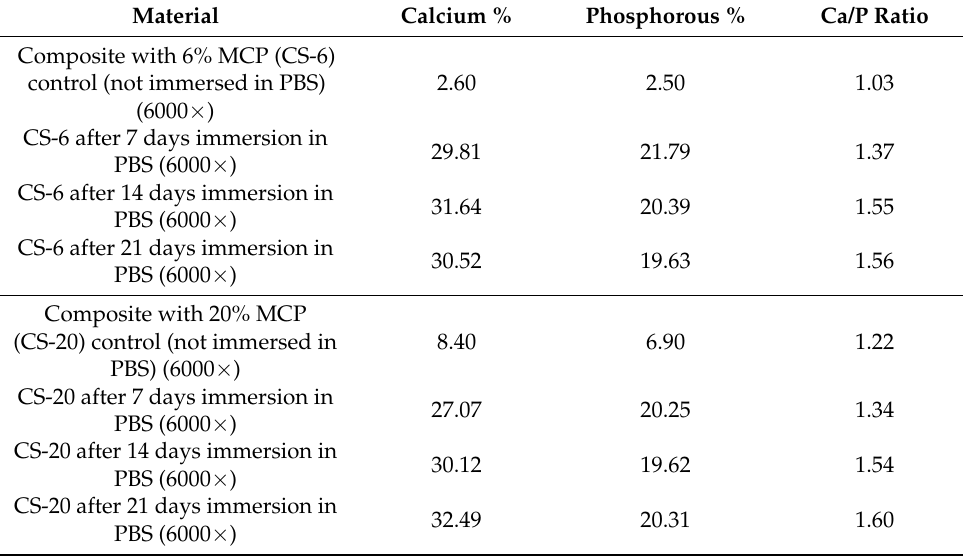
Table 4. EDS analysis of calcium and phosphorous atom ratios observed on the surface of CS-6 and CS-20, before and after immersion in PBS for 21